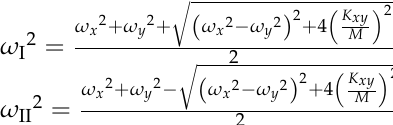
Figure 8. Schematic of the LabVIEW TM program.